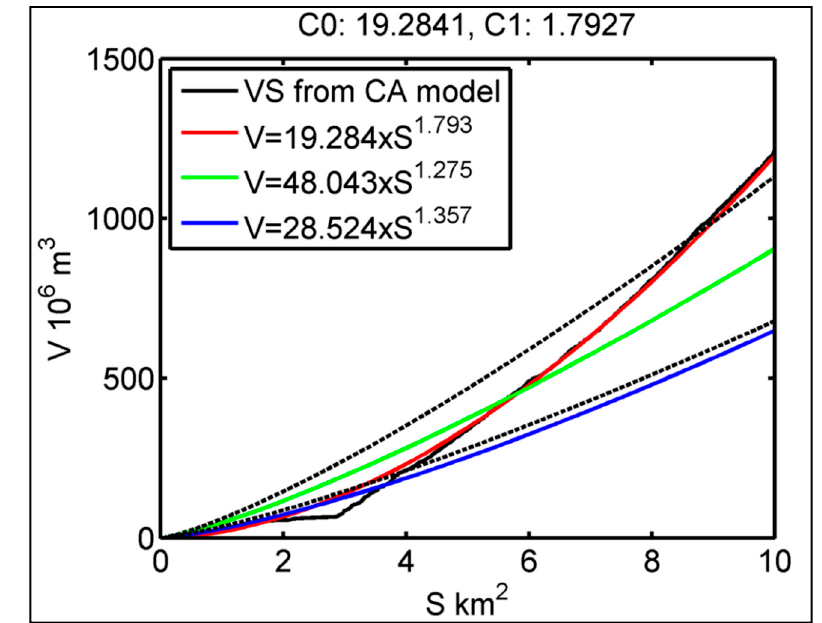
Figure 10. The V-S scaling of QUE from the CA model and its fitting with scaling factors (red) for the comparison with the V-S scaling from six individual glaciers [64], including QUE (green), and the V-S scaling from a previous study [19]. The black dotted line is the 25% error estimation from the V-S scaling from six individual glaciers in the Cordillera